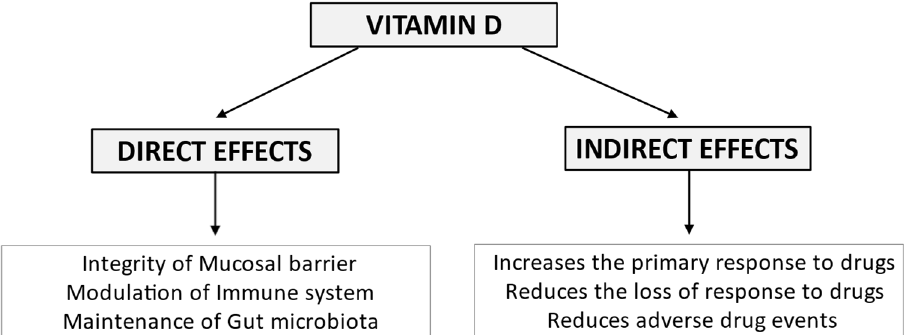
Figure 3. Vitamin D exerts its biological effects on the intestine in IBD maintaining mucosal barrier integrity, modulating the immune system and the composition of the gut microbiota. Emerging evi- dence suggests that vitamin D deficiency may unfavorably affect response to biological therapy, being associated with an increased risk of both primary non-response and secondary loss of response to the drugs. Furthermore, vitamin D deficiency may worsen corticosteroid-related osteopenia/osteoporosis and increase the risk of immunomodulator-related